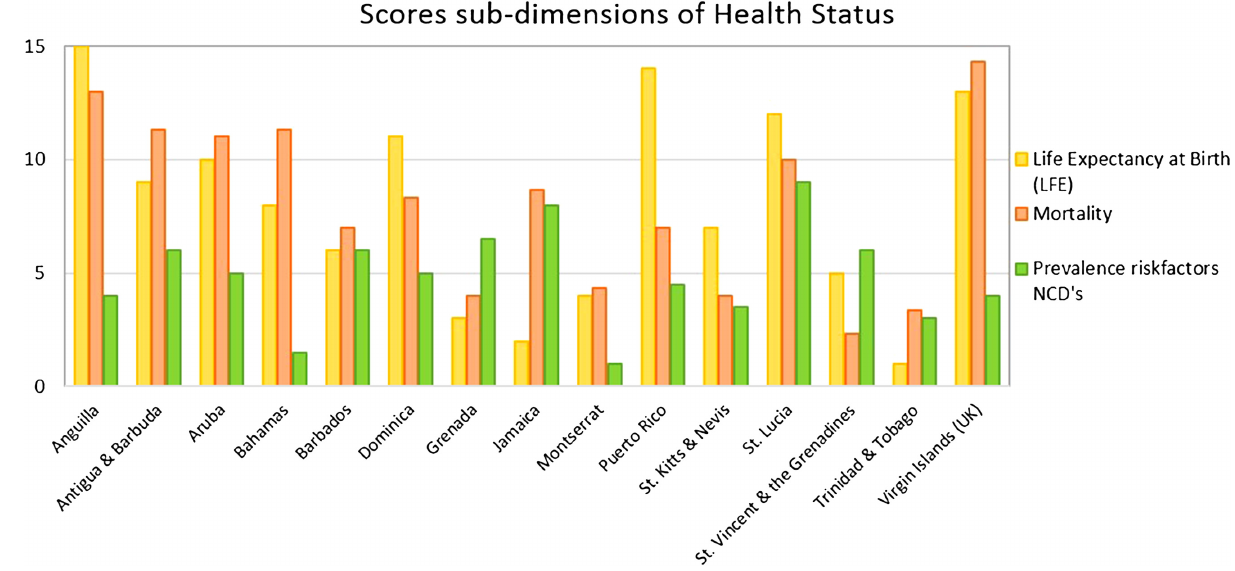
Figure 3 . Average scores sub-dimension of health